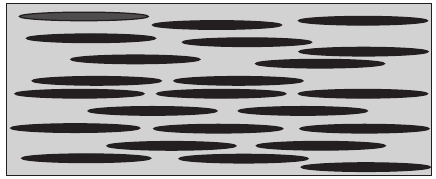
Figure 3 Parallel clay platelets